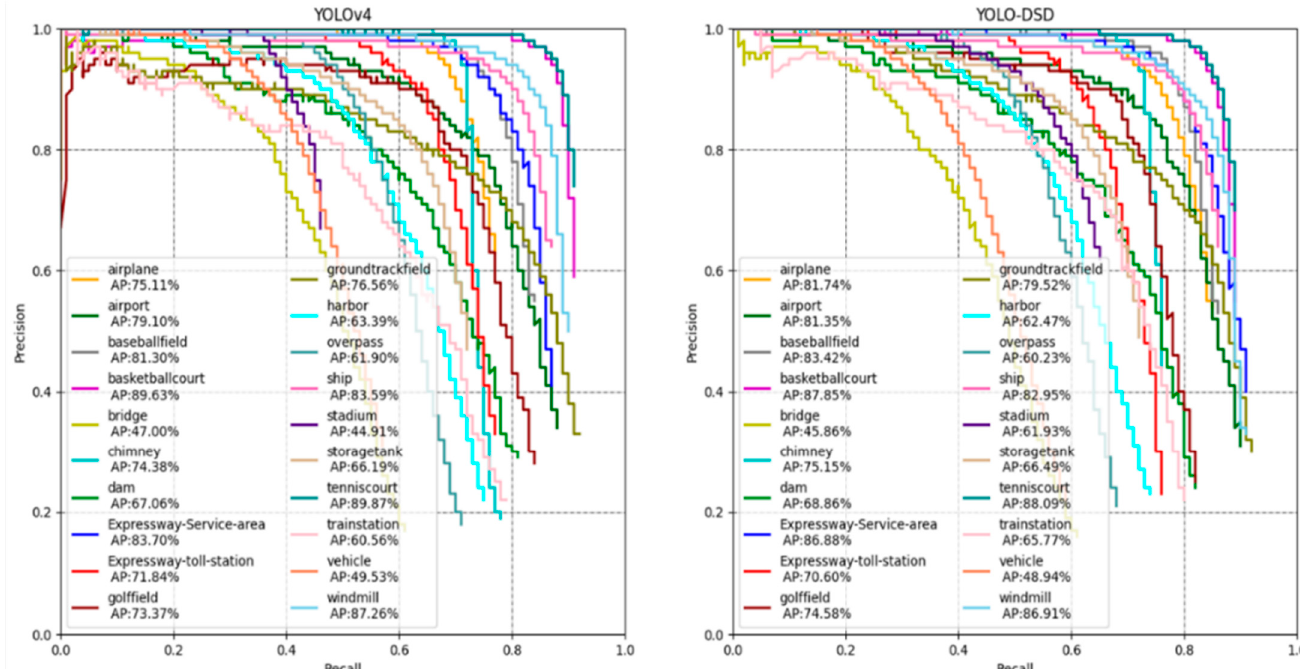
Figure 18. The precision–recall curves and AP (IOU = 0.5) of YOLOv4 and YOLO-DSD in each category.